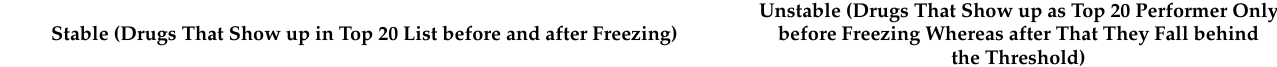
Table 2. The list of stable and unstable drugs for IPS11-pSin-TP53.